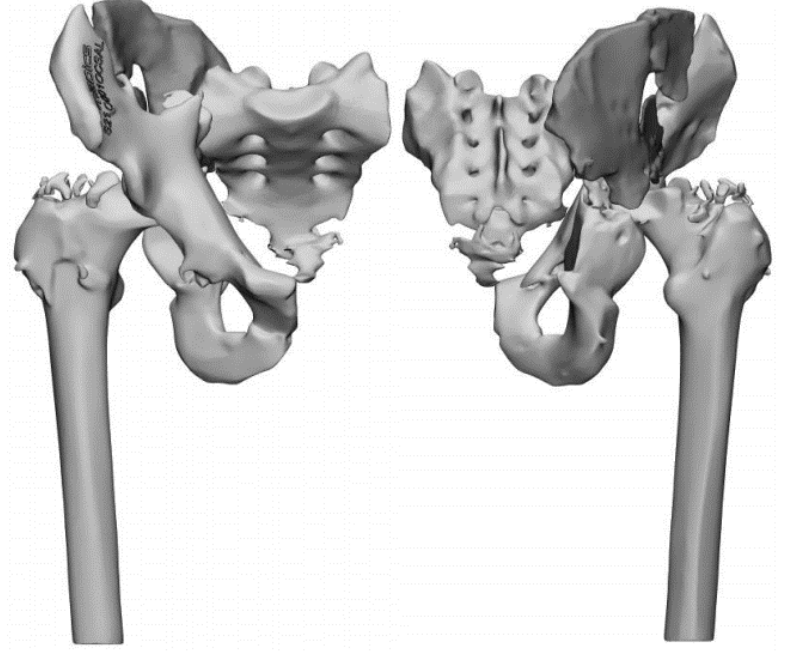
Figure 3. 3D reconstruction of the pelvis before the second stage.